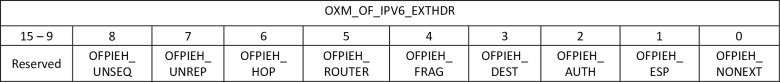
OXM_OF_IPV6_EXTHDR match field in OpenFlow standard.